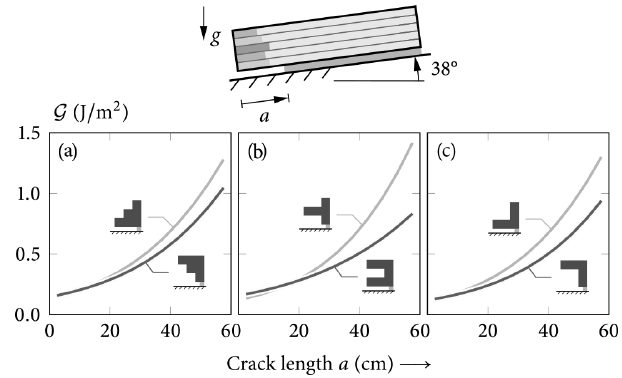
Figure 14. Comparison of total differential energy release rates G of cracks of length a in a 2.5m long PST between the considered benchmark